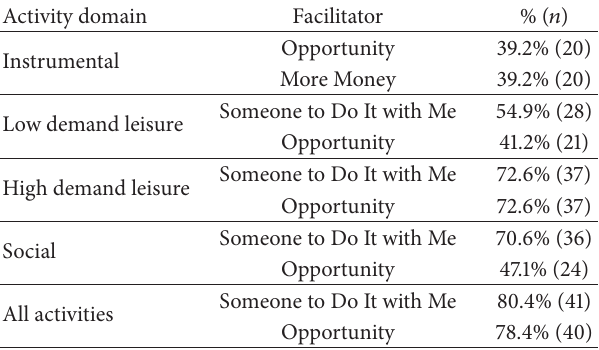
Table 4: Most common facilitators by activity domain ( 𝑛 = 51 ).